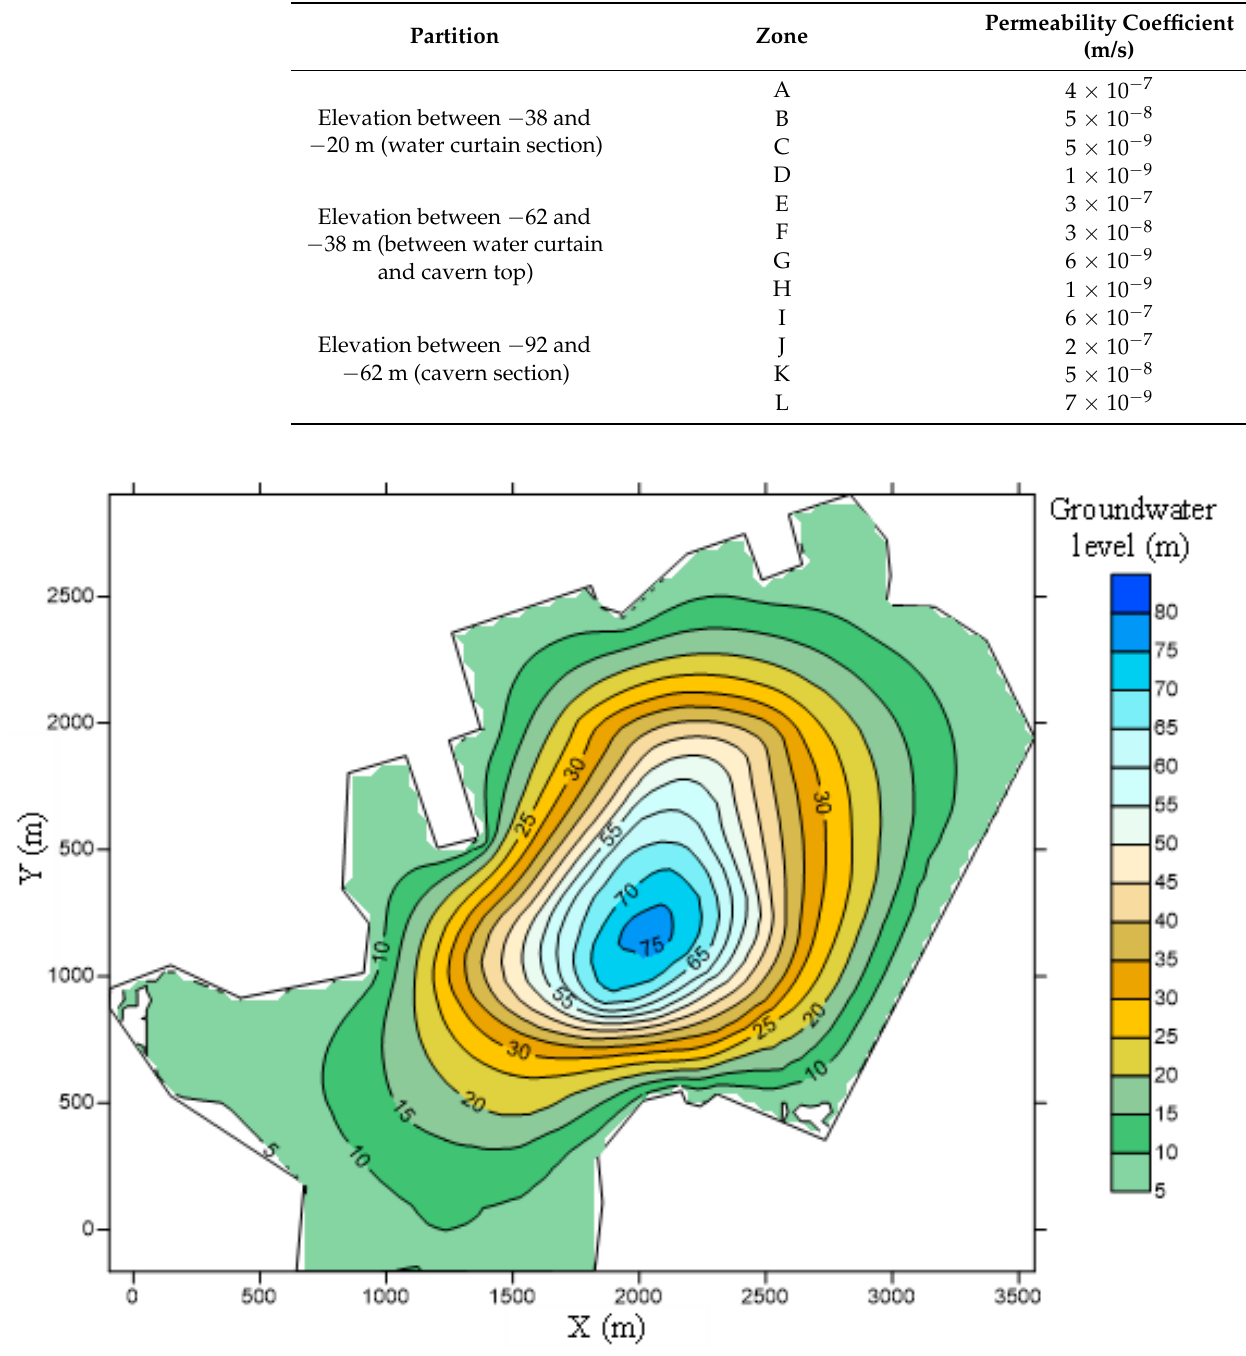
Figure 8. Isolines of modeled natural groundwater level in the reservoir area under high tide con- ditions.